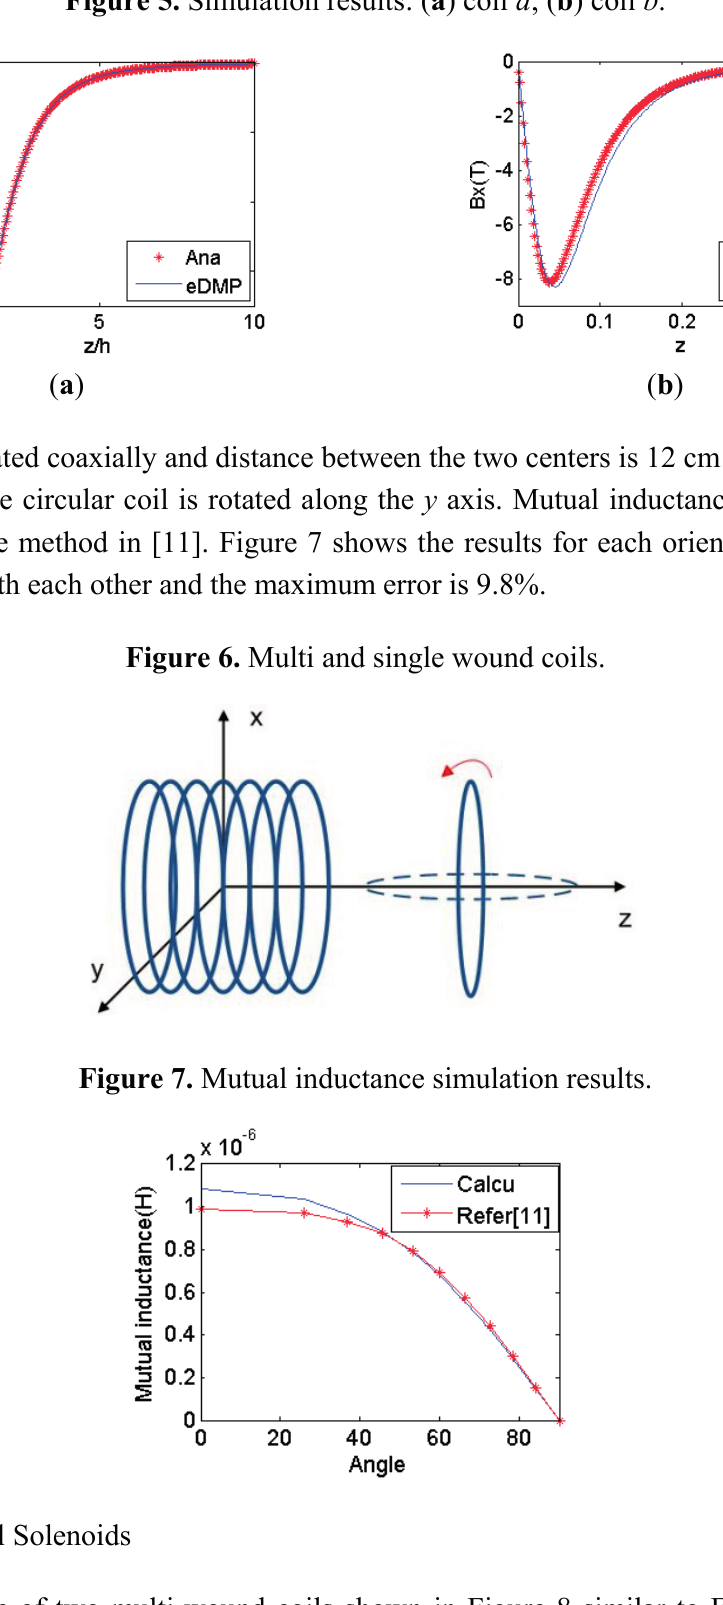
Figure 5. Simulation results: ( a ) coil a ; ( b ) coil b .